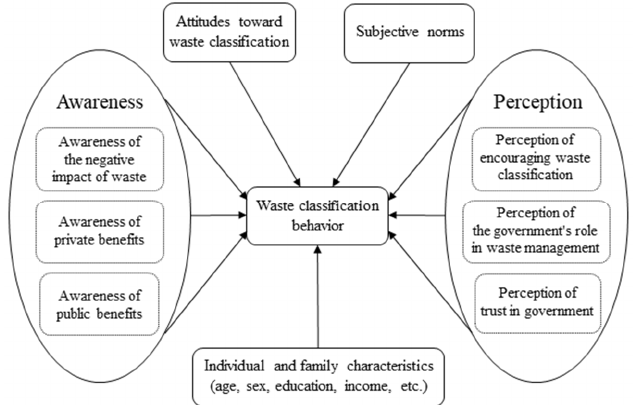
Figure 1. Theoretical analysis framework.